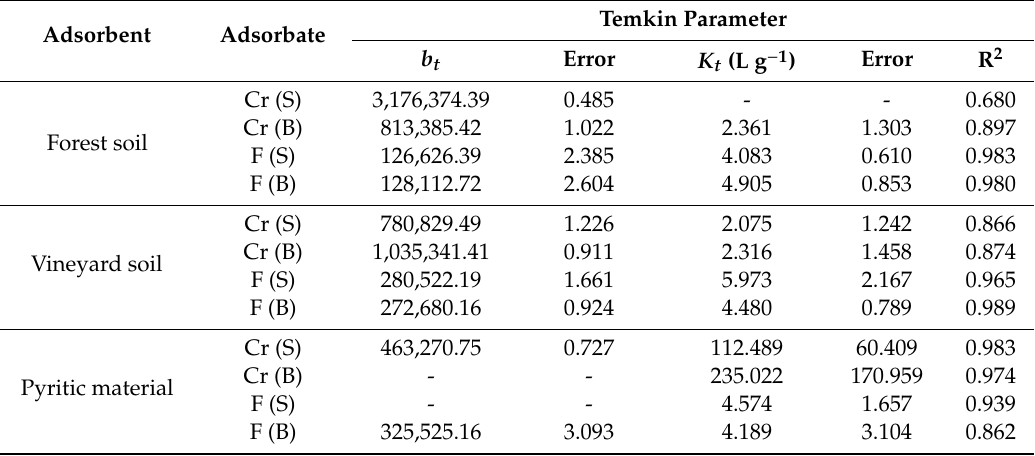
Table 3. Parameters of the Temkin model for Cr(VI) and F − in individual simple (S) and competitive binary (B)